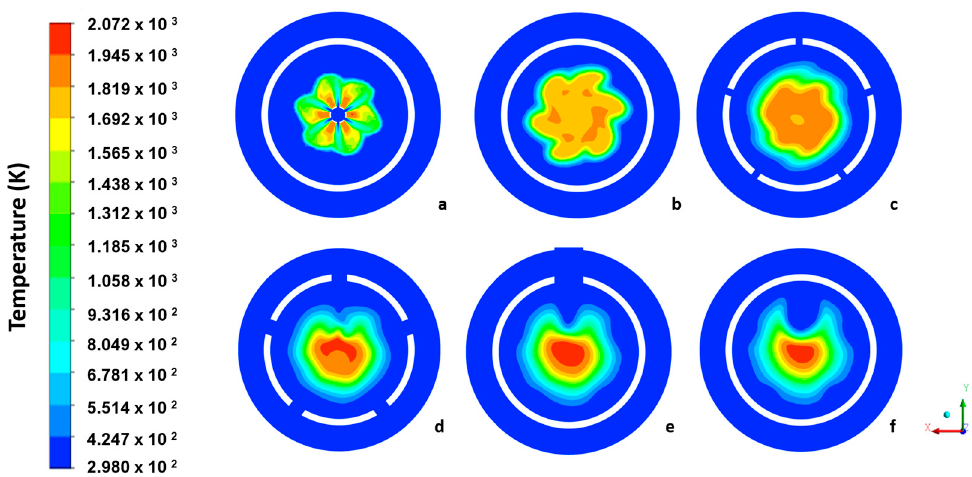
Figure 8. Temperature profiles at transverse plane of the combustion chamber: ( a ) plane 1; ( b ) plane 2; ( c ) plane 3; ( d ) plane 4; ( e ) plane 5; ( f ) plane 6.